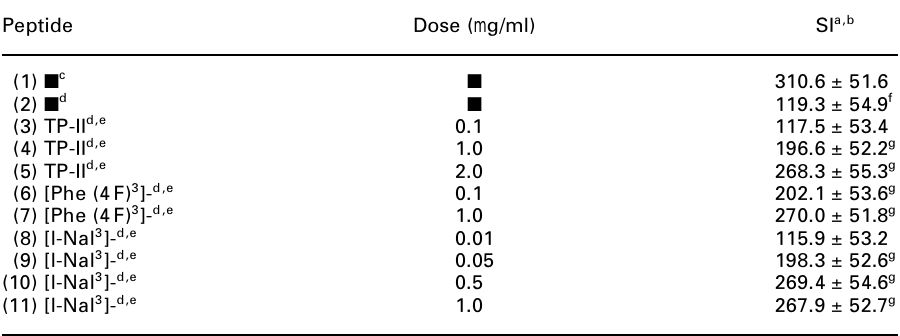
Table 1. Effect of synthetic TP-II, [Phe (4F) 3 ] – and [l-Nal 3 ]-TP-II on impaired PHA-stimulation of T-lymphocytes of uremic patients Peptide